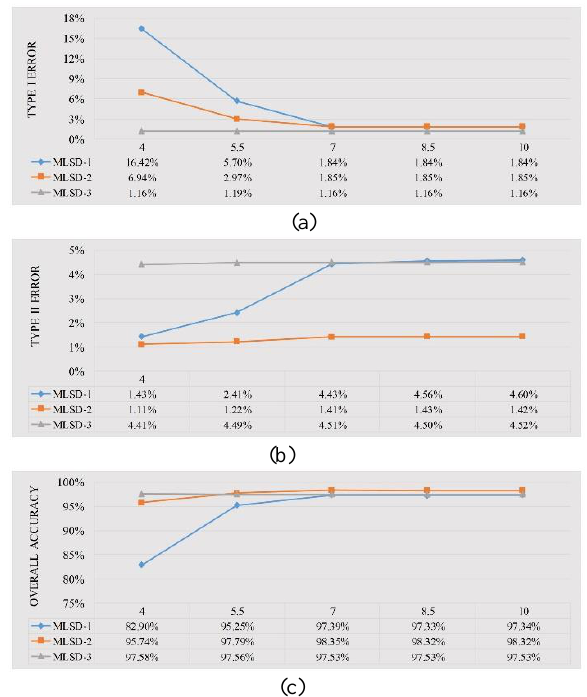
Fig. 7 S Sensitivity tests with the local elevation threshold ( h e ): (a) Type I error, (b) Type II error, and (c) Overall accuracy